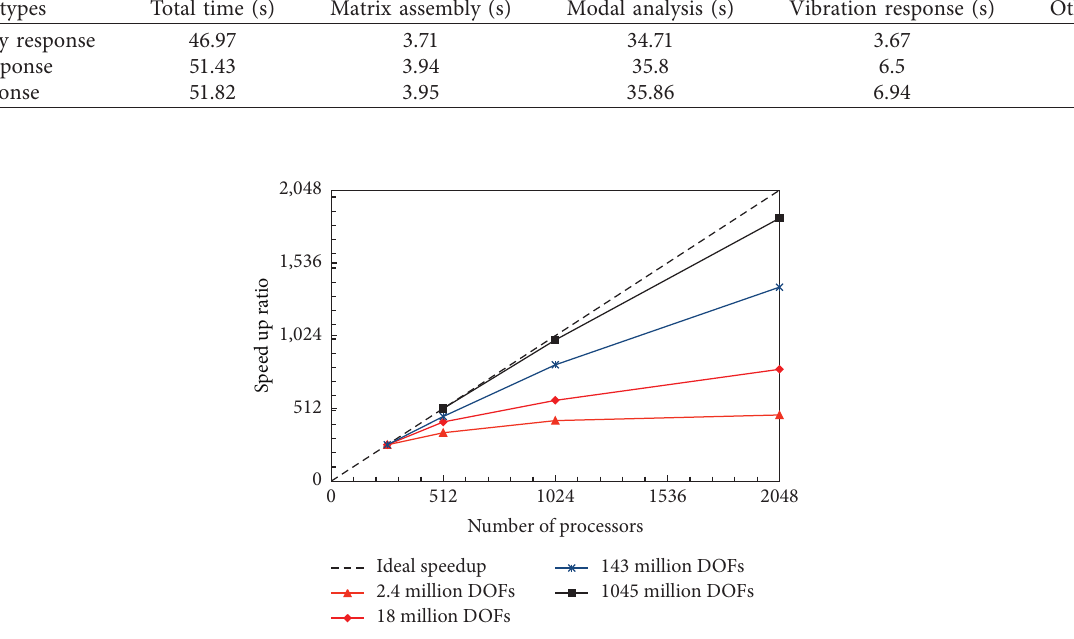
Figure 17: Speedup curves for different DOFs of reentry